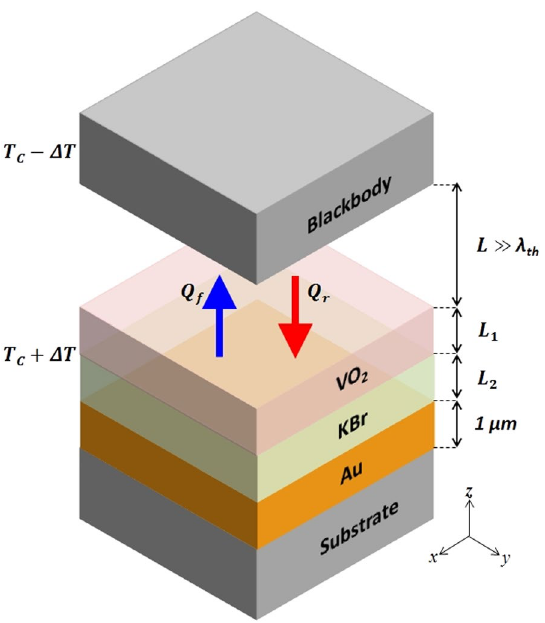
Figure 1. Schematic of a far-field thermal diode with a high rectification ratio. The active component has a tri-layer structure consisting of VO 2 , KBr and gold thin films on a substrate with thicknesses L 1 , L 2 and 1 μ m, respectively. The passive component is a blackbody. T c = 341 K is the phase transition temperature of VO 2